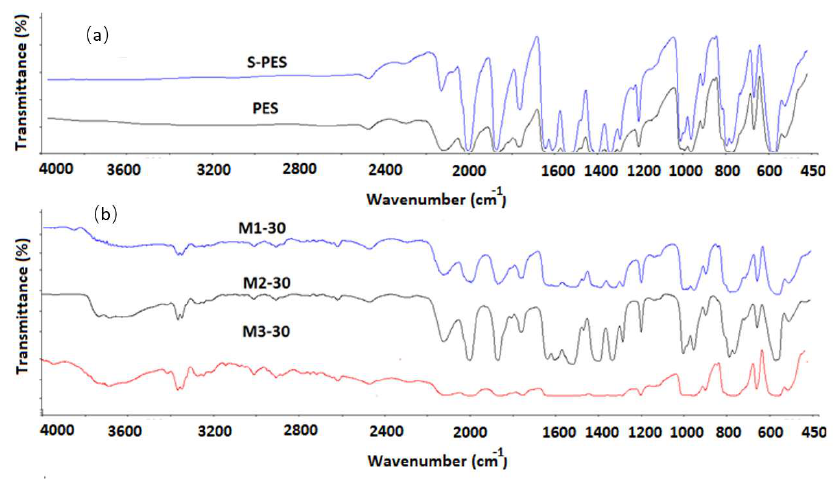
Figure 4. ( a ) FTIR spectra of S-PES and PES, ( b ) Nanocomposite membranes.